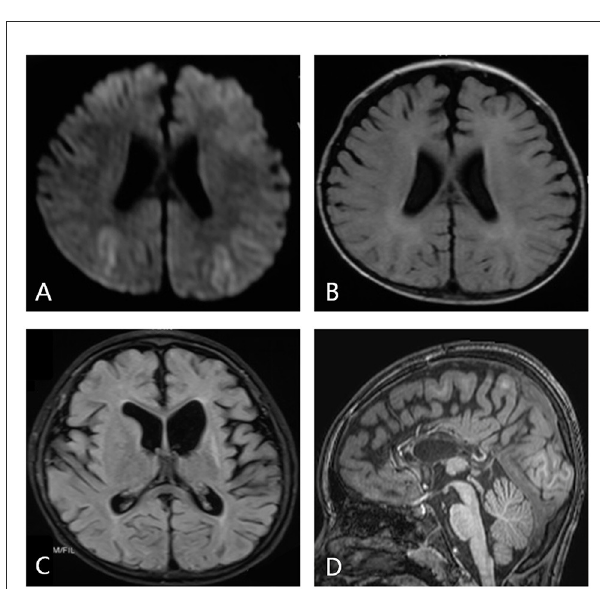
FIGURE3 Neuroimaging data of case 2. During the acute phase of viral encephalitis, MRI shows an abnormal signal in the bilateral frontal and parietal regions on diffusion-weighted imaging (A) and T1-weighted imaging (B) . MRI reveals a more obvious signal on the left side, and dilation of the left lateral ventricle is observed (C) . Imaging shows completed corpus callosotomy (D) .